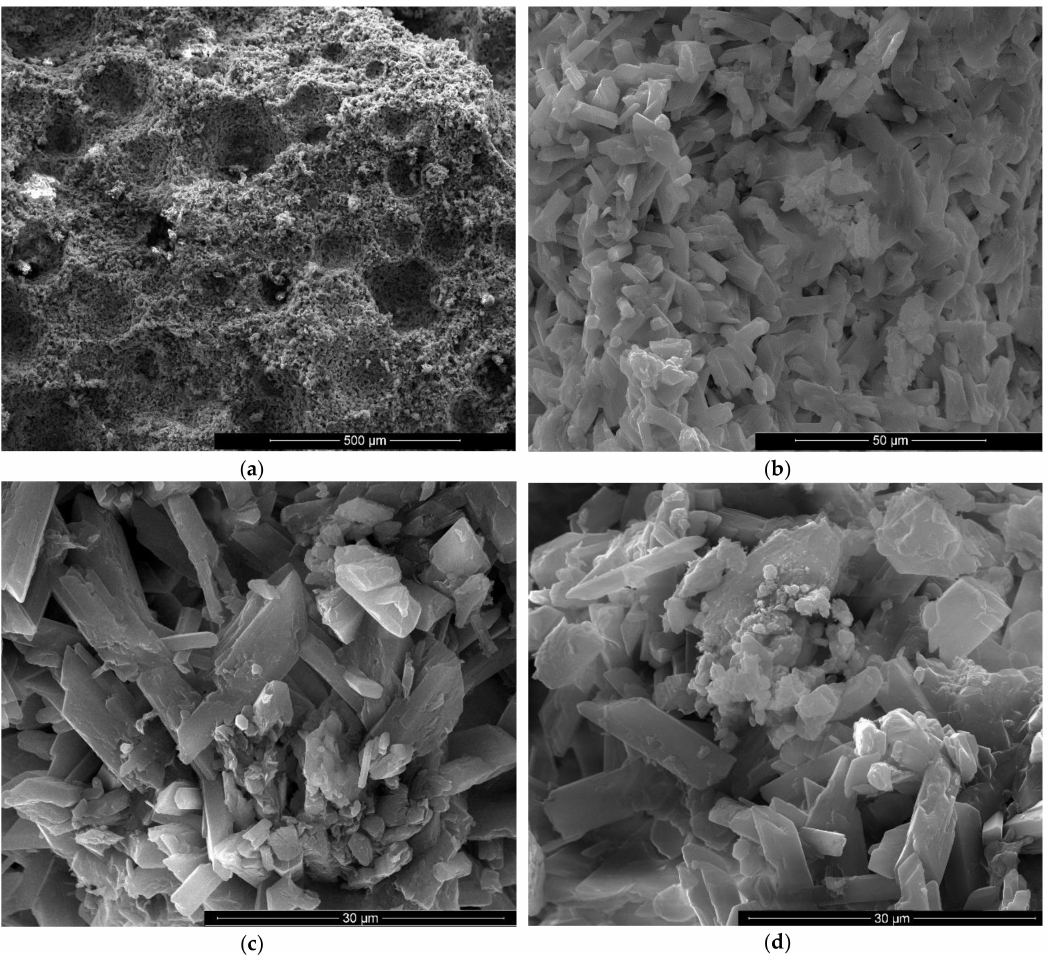
Figure 8. SEM images of gypsum binder with 1% FGD and 1% sodium bicarbonate addition (IG1B1) after 7 days of hardening in air with various magnifications: ( a ) × 200; ( b ) × 2000; ( c ) × 5000; ( d ) × 5000.